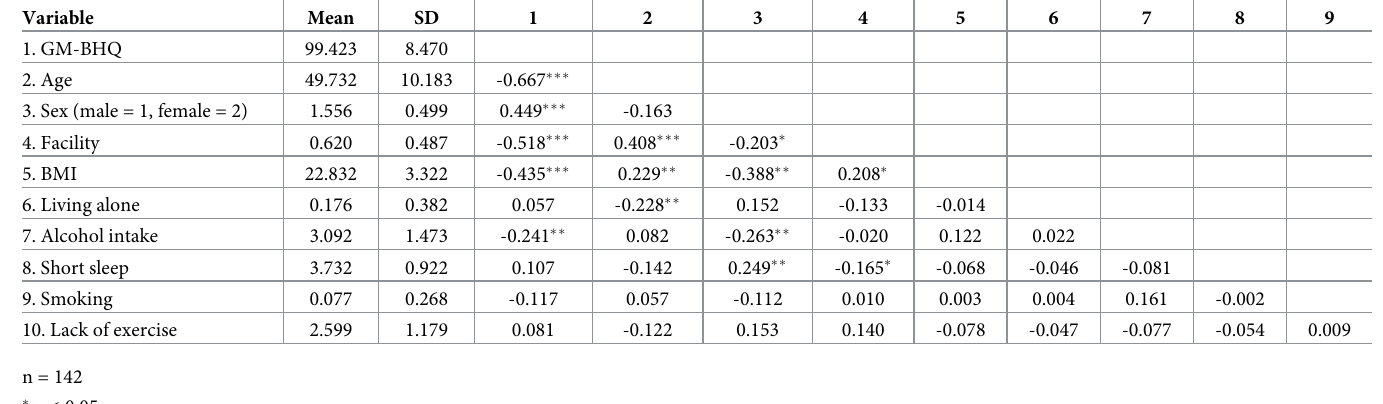
Table 2. Descriptive statistics and